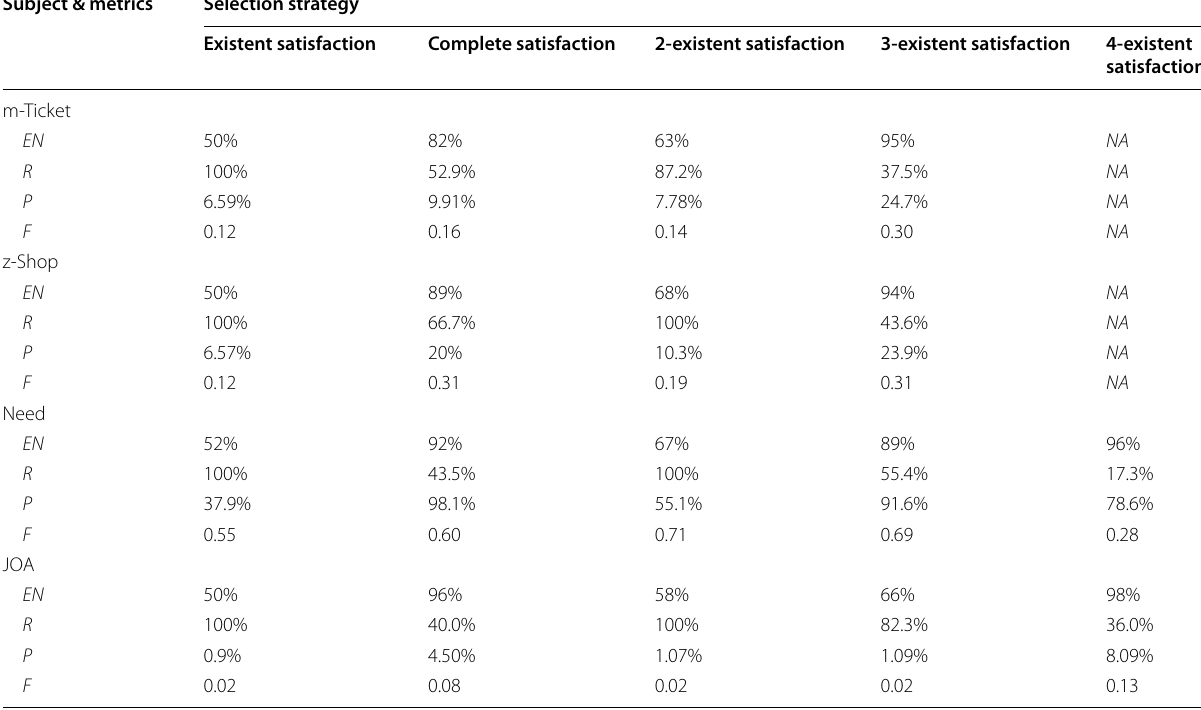
Table 6 Data of Experiment